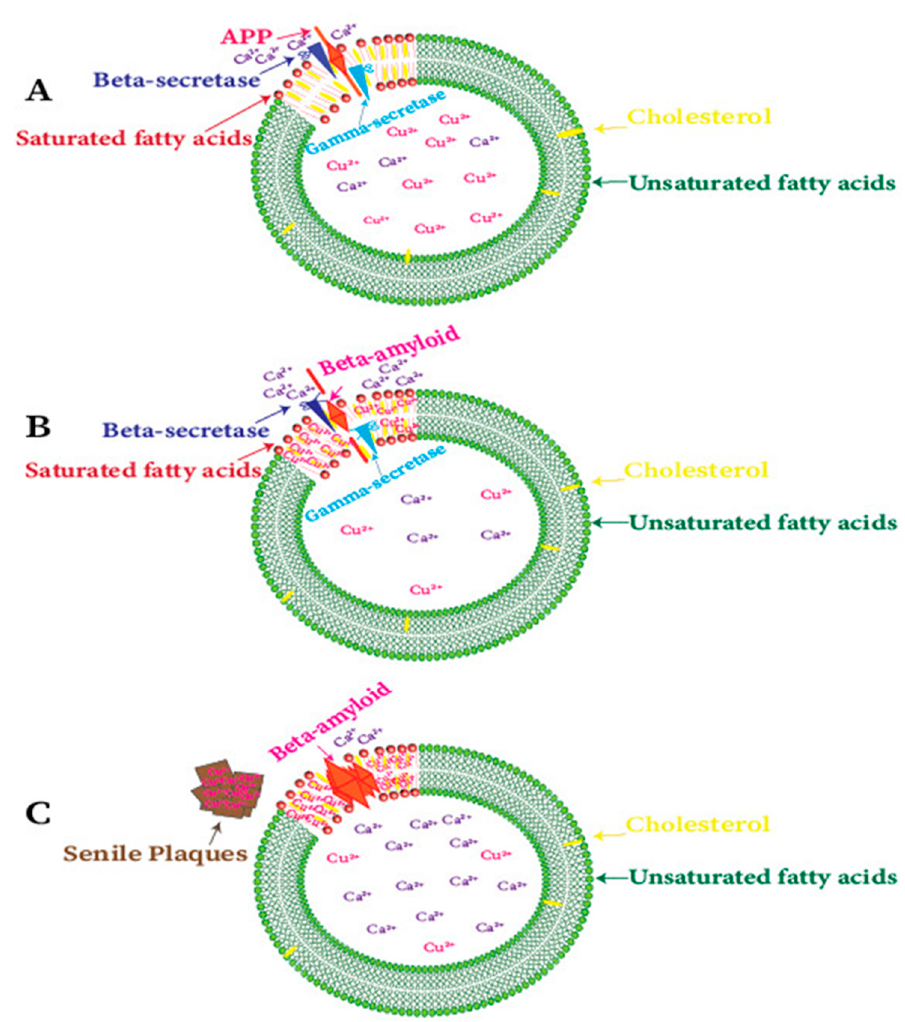
Figure 4. Schematic representation of the e ff ects and correlation between Cu and cholesterol-rich lipid rafts in Alzheimer’s disease. ( A ) The enzymes that are present in lipid rafts are responsible for the cleavage of APP to A β peptide. ( B ) Cu deficient AD brains lead to copper accumulation in lipid rafts, and rising concentrations of Cu results in higher A β production due to an increase in β -secretase activity. ( C ) Calcium-permeable pores formed by small oligomers of A β peptides. These pores are calcium channels and disrupt cellular Ca 2 + homeostasis, eventually leading to neuronal